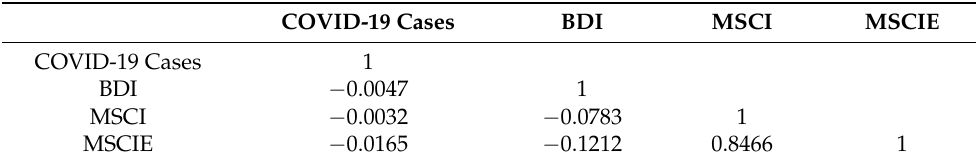
Table 2. Correlation matrix.